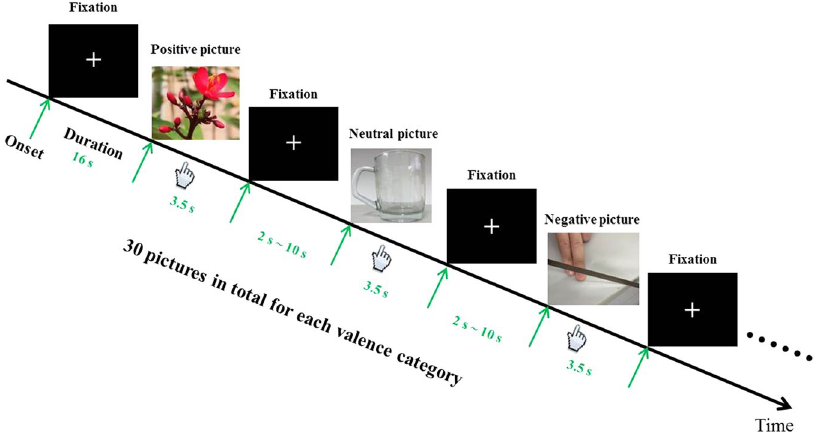
Figure 1. The experimental paradigm for the emotional valence-evaluation task. The task includes three valence categories of pictures (i.e., positive, neutral, and negative) and 30 pictures for each valence category. All pictures are presented for 3.5 s in a pseudorandom manner, followed by a fixation for 2 s, 4 s, 6 s, 8 s, or 10 s as an inter-stimuli-interval. Participants were asked to indicate the valence of the picture with a button-press action as quickly as possible. The subjects response to the different stimuli using the different fingers in two hands (i.e., positive, neutral, and negative stimuli corresponding to right index finger, right middle finger, and left index finger respectively). The emotional and neutral images presented are not from the International Affective Picture System, but rather, are representative